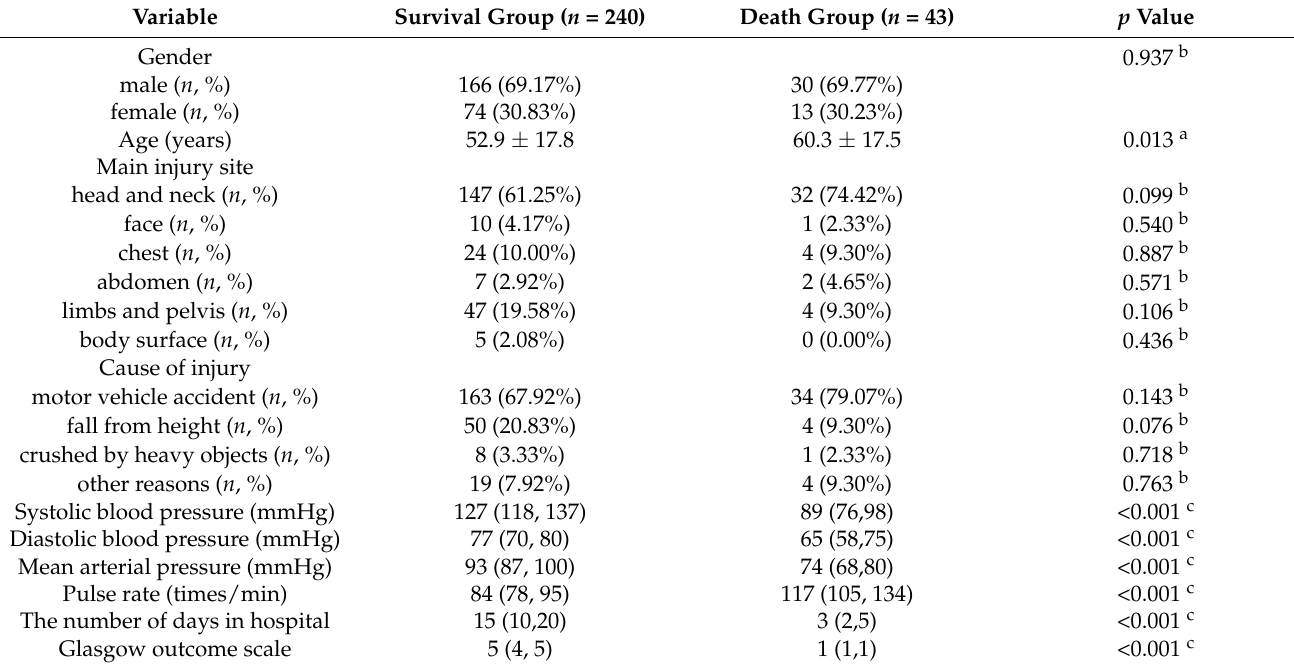
Table 1. Comparison of basic clinical data between survivor group and death